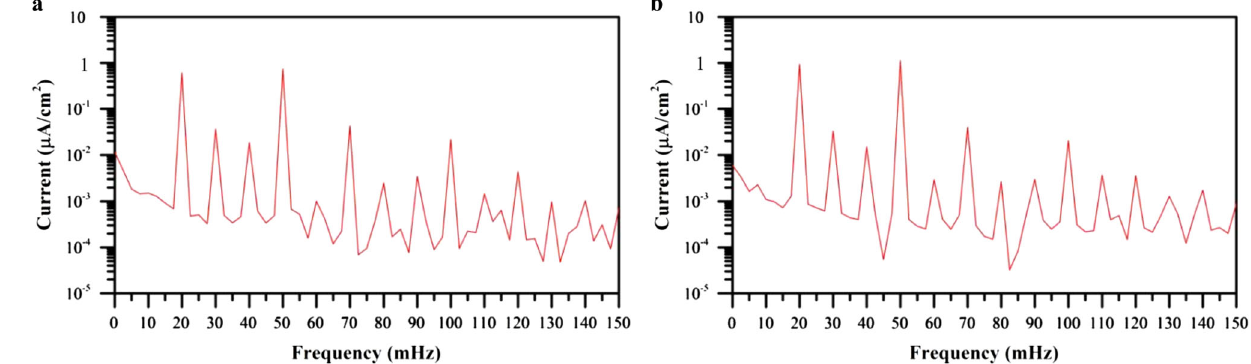
Fig. 1 Intermodulation spectrum from electrochemical frequency modulation for SS316: a exposed to supercritical water at 530 °C, b exposed to ultra-supercritical water at 600